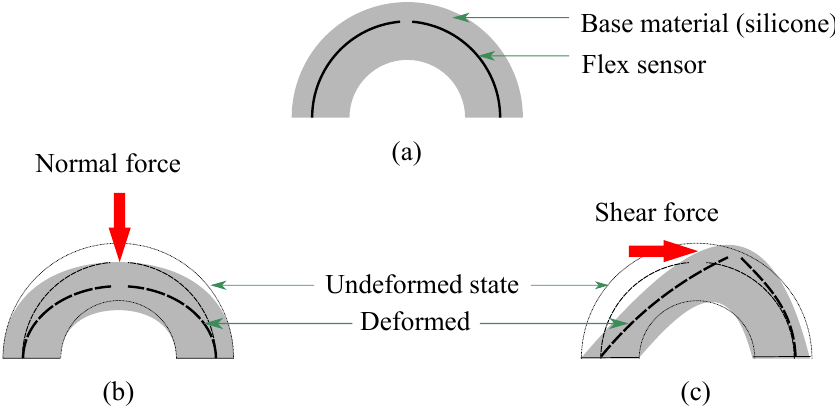
Figure 1. Schematic diagram of the ( a ) sensor structure, and working principle of the multi-directional force sensing system against ( b ) normal and ( c ) shear force; red arrows depict applied force